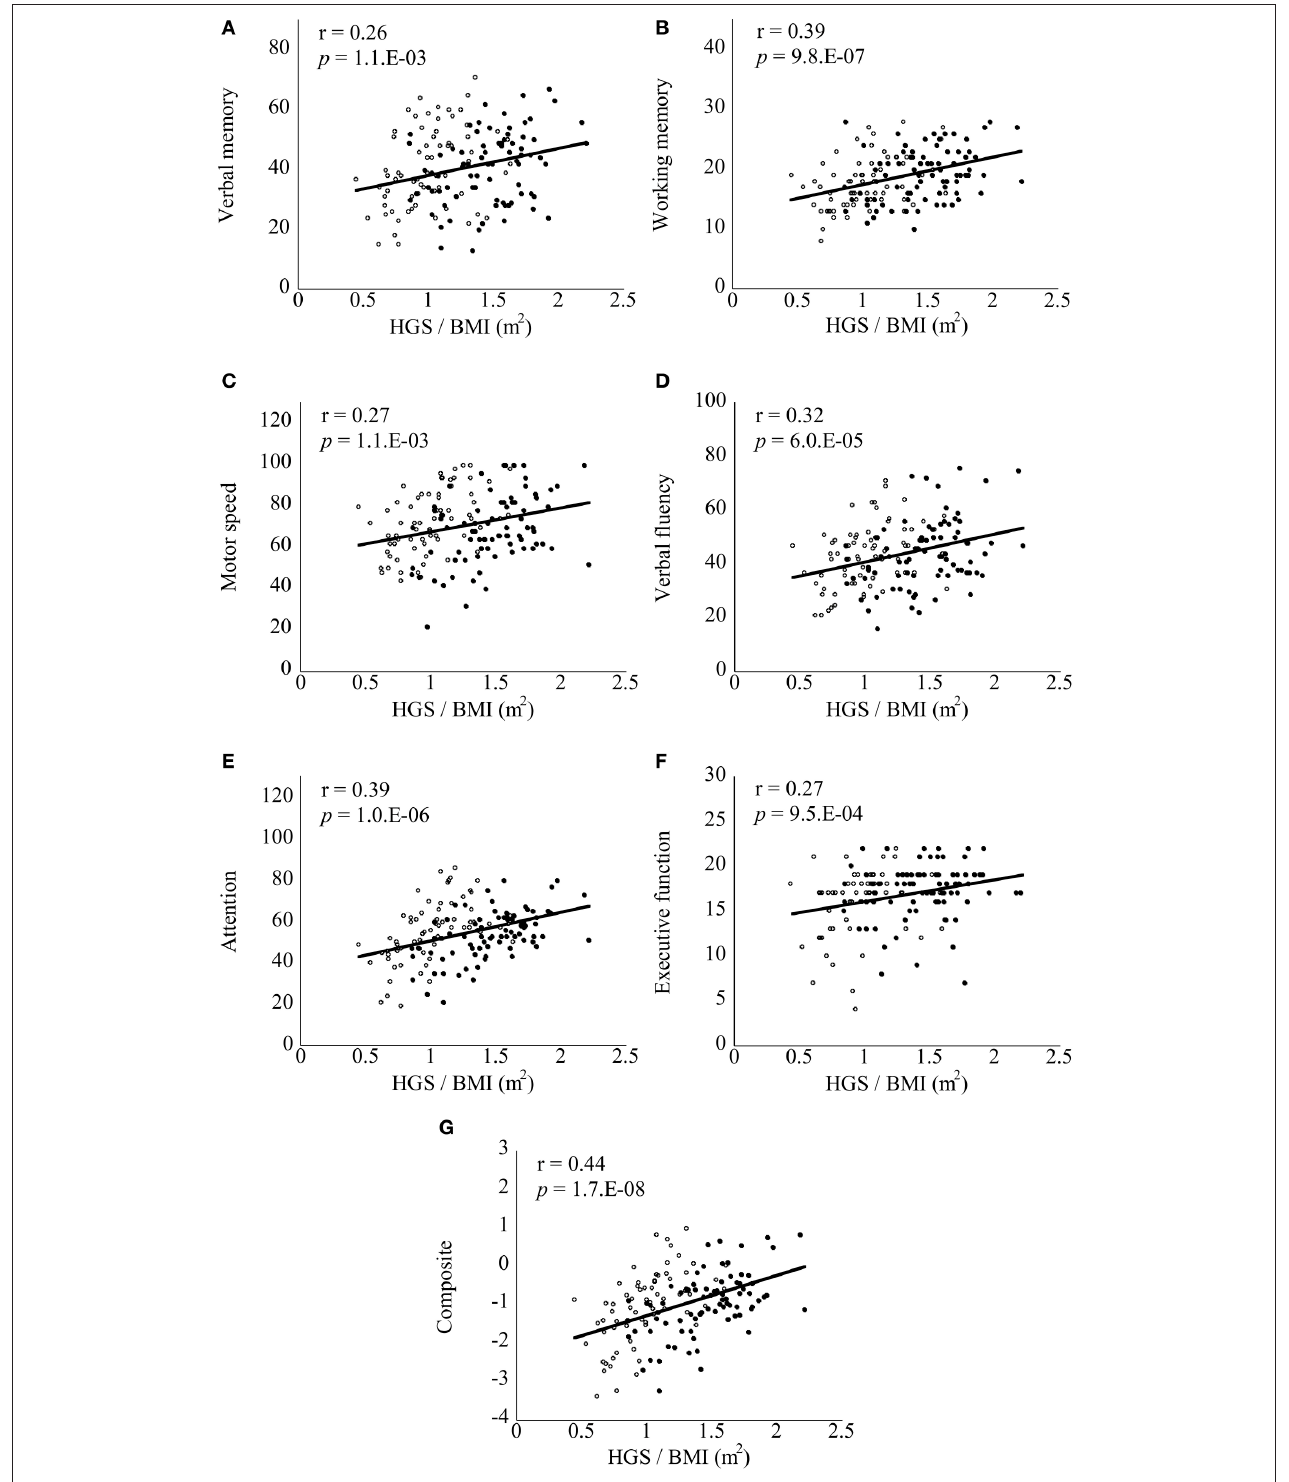
FIGURE 1 | Scatter plots of correlations between handgrip strength (HGS)/body mass index (BMI) and Brief Assessment of Cognition in Schizophrenia (BACS) scores in patients with schizophrenia. HGS/BMI positively correlated with all of the BACS scores (A–G) in the patients with schizophrenia (all p < 0.0071, corrected for multiple testing). Black and white circles indicate male and female patients, respectively. Significant p -values are shown in exponents. r, Pearson’s correlation coefficient.